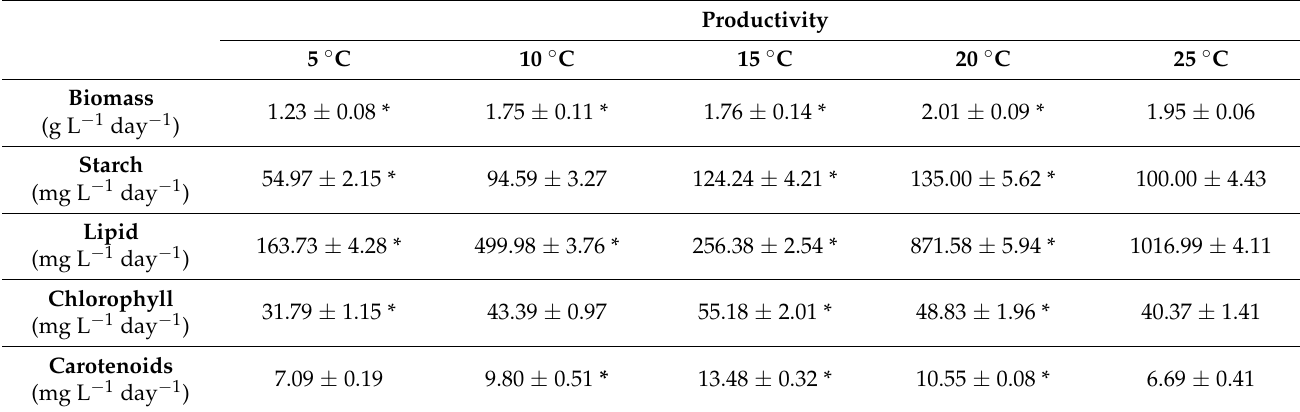
Figure 1. Growth of C. reinhardtii under different temperatures. All data are means ± SD of three biological replicates. Different lowercase letters indicate significant differences between 25 ◦ C and each temperature ( p < 0.05). Table 1. The productivity of biomass, starch, lipid, chlorophyll, and carotenoids. All data are means ± SD of three biological replicates. Significant differences between 25 ◦ C and each temperature are indicated by asterisks (*) ( p <